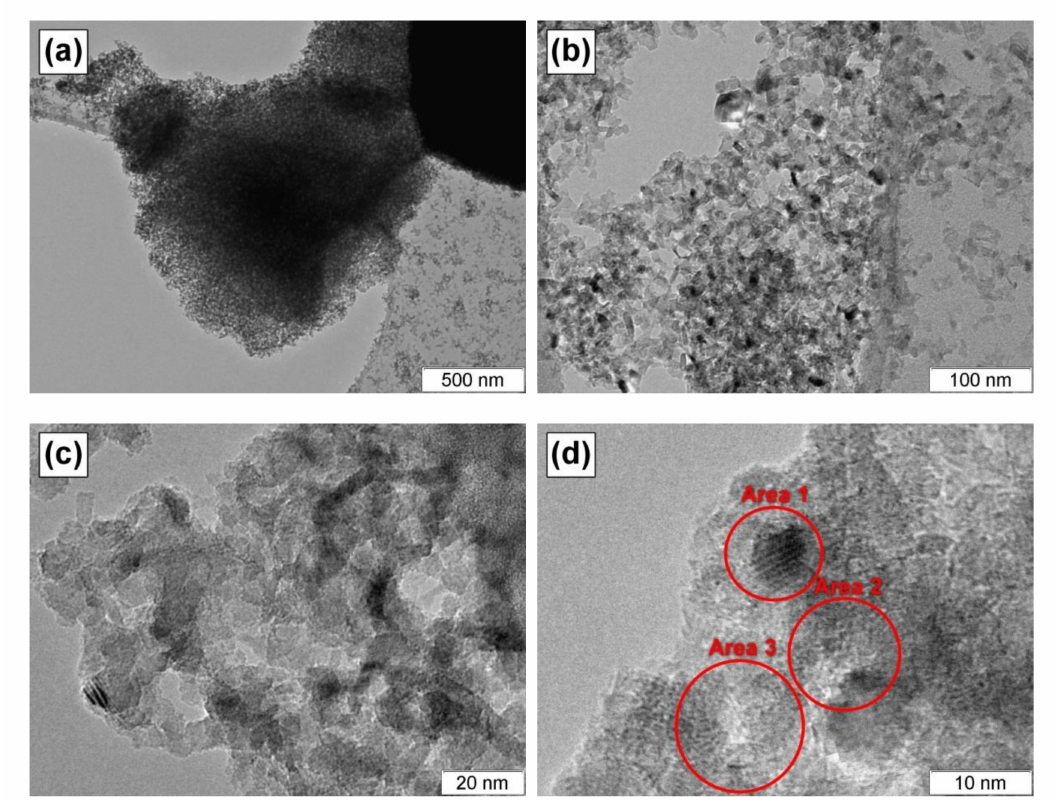
Figure 3. TEM images of the sol-gel prepared Ni-Mo-Mg-O sample at various magnifications: